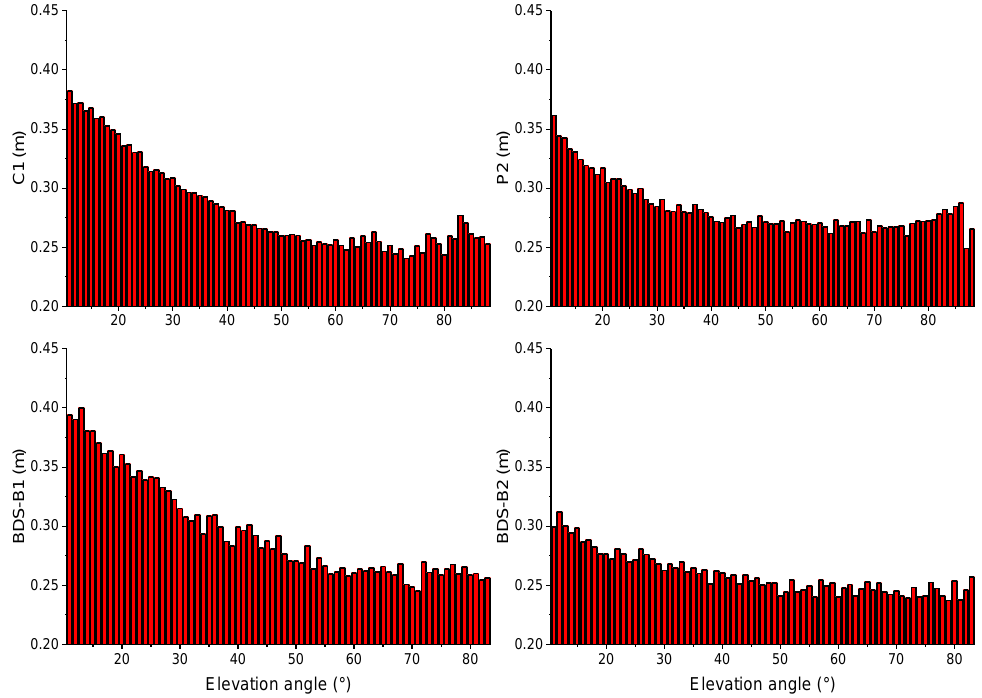
Figure 9. Relationship between precision and elevation angle of GPS and BeiDou Navigation Satellite System (BDS) code measurements.